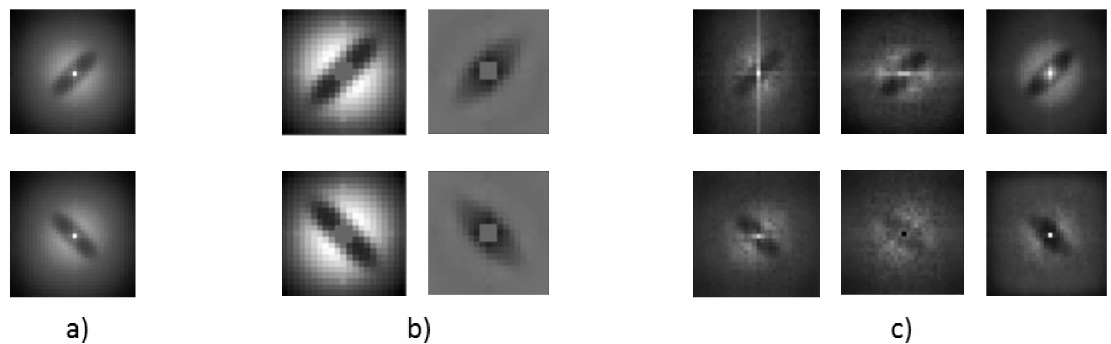
Figure 3. ( a ) Trained LMS-filters from blocks with embedded orientations 45 ◦ and 135 ◦ ; ( b ) First two PCA components for 45 ◦ and 135 ◦ ; ( c ) Three atoms from learned dictionaries for 45 ◦ and 135 ◦